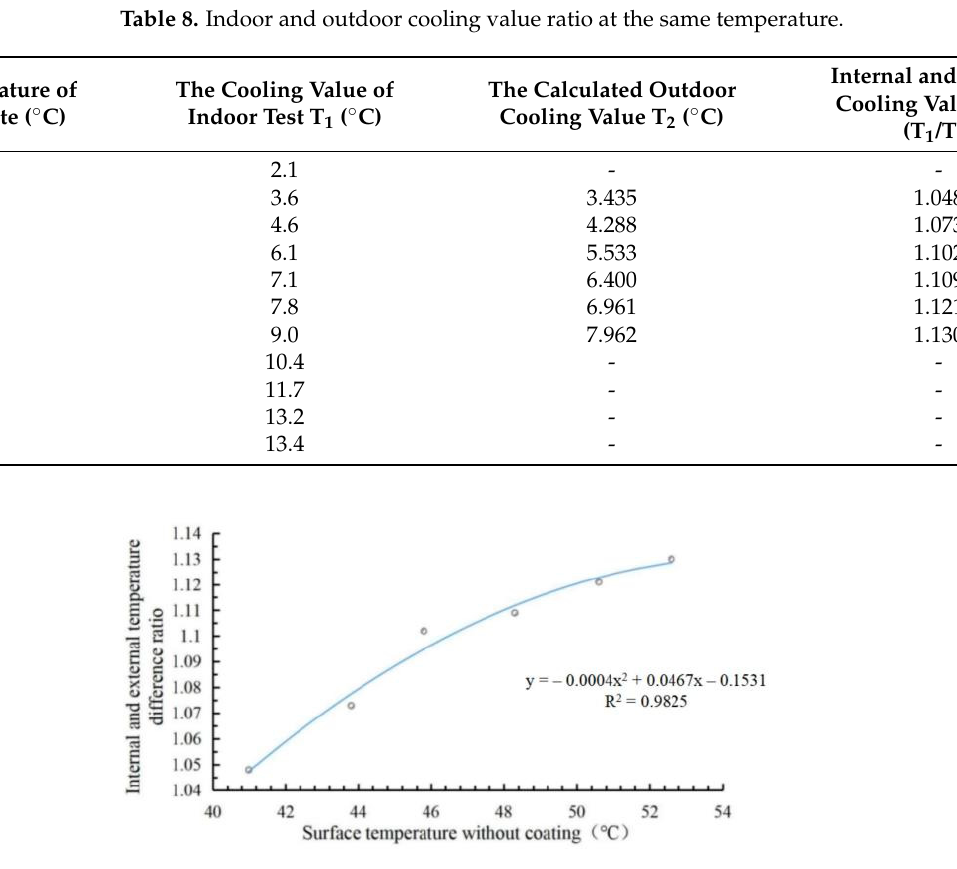
Figure 18. Pavement cooling value diagram.